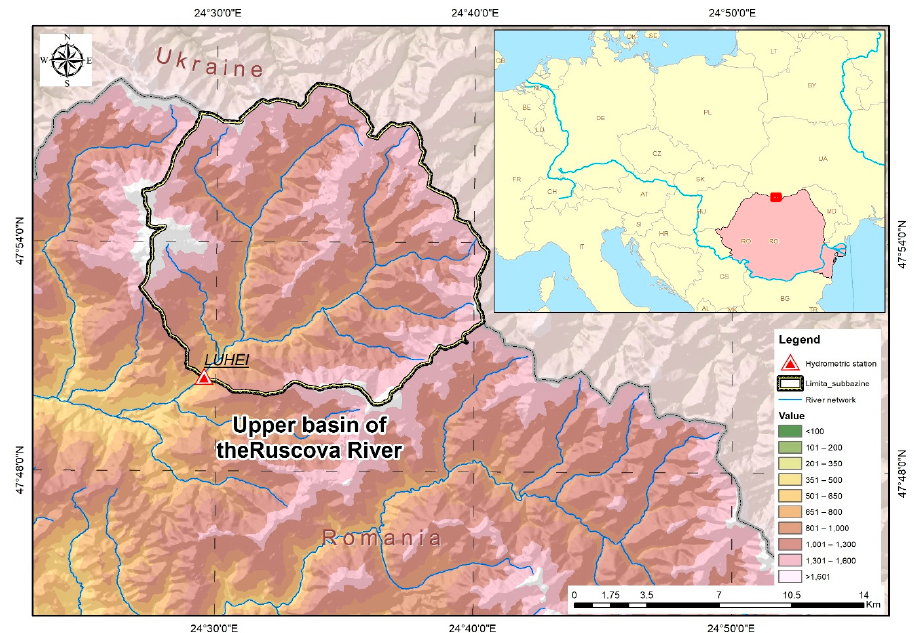
Figure 1. Study area and location of the considered hydrometrical station.